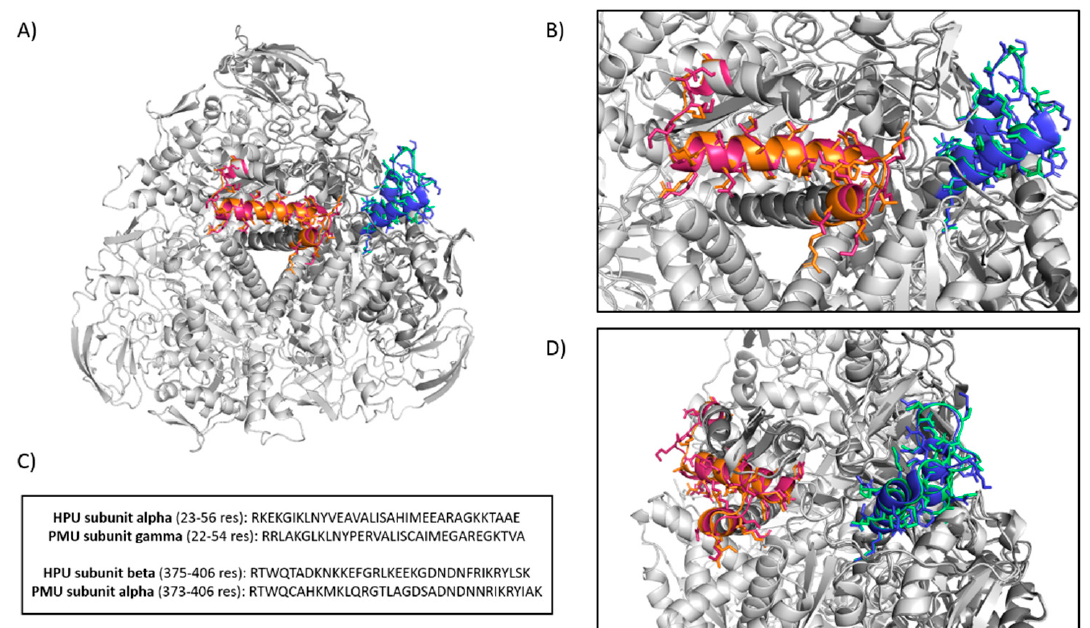
Figure 7. Nuclear localization sequences in P. mirabilis (PMU) and H. pylori (HPU) ureases. Panels ( A – D ) show the nuclear localization sequences (NSL) in P. mirabilis and H. pylori ureases. Panel ( A ) illustrates the 3D cartoon models of P. mirabilis urease in its ( γβα ) 3 oligomer (light gray) superimposed to H. pylori urease in its ( αβ ) 3 form (dark gray). The NLSs in PMU are pictured in orange (positions 22–54) and green (positions 575–608) and in HPU, they are shown in pink (positions 21–56) and blue (positions 613–646). The sequences corresponding to the NLS are presented in panel ( C ). Closer views of the two bipartite NLSs present in HPU and PMU are seen in Panels ( B , D ) (90 degree turn). Images were built with PyMOL.